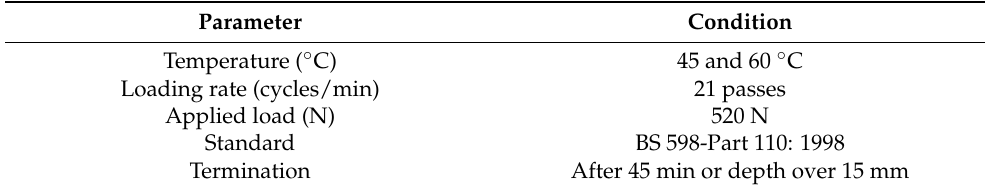
Table 13. Parameters of the rutting depth